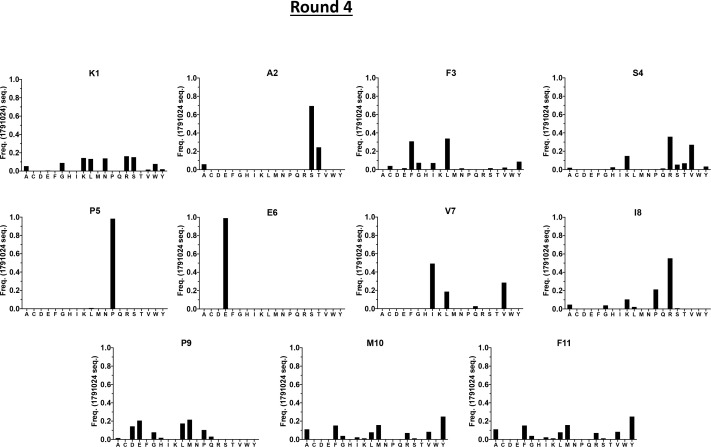
Individual amino acid frequencies of the AGA1 TCR-selected, HLA-B*57:03-restricted yeast display peptide repertoire following Round 4 selection.Individual amino acid frequencies along the length of the 11 amino acid peptide are illustrated in bar chart format, with the frequencies of peptide sequence reads represented on the Y axis. Individual amino acids at each position of the 11mer peptide are represented on the X-axis. K1, A2, F3 refers to amino acid positions 1, 2, 3, etc, of the HIV KF11 peptide sequence, which is included for reference.
Figure 2—figure supplement 5—source data 1.Amino acid signatures of Yeast display libraries-AGA1 TCR Round 3 selection.